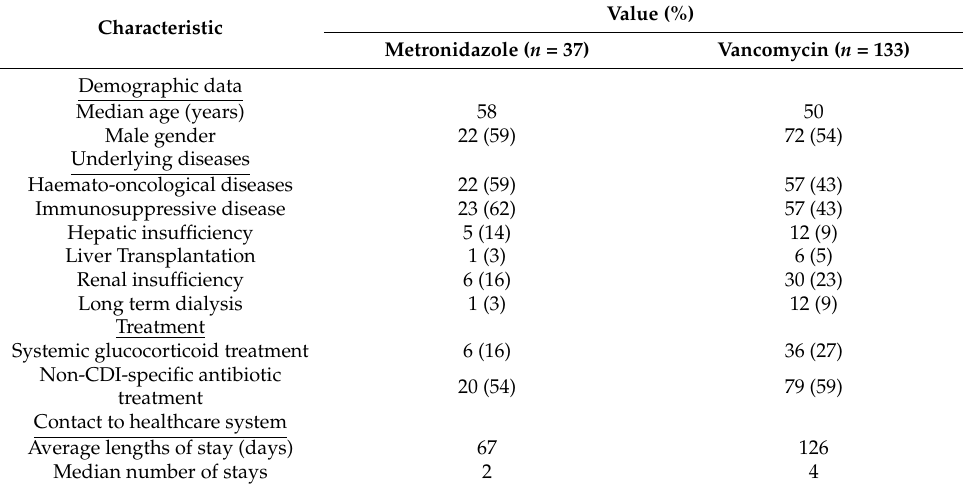
Table 1. Comparison of demographic and clinical characteristics of patients meeting the inclusion criteria and treated with metronidazole or oral vancomycin ( n = 170).